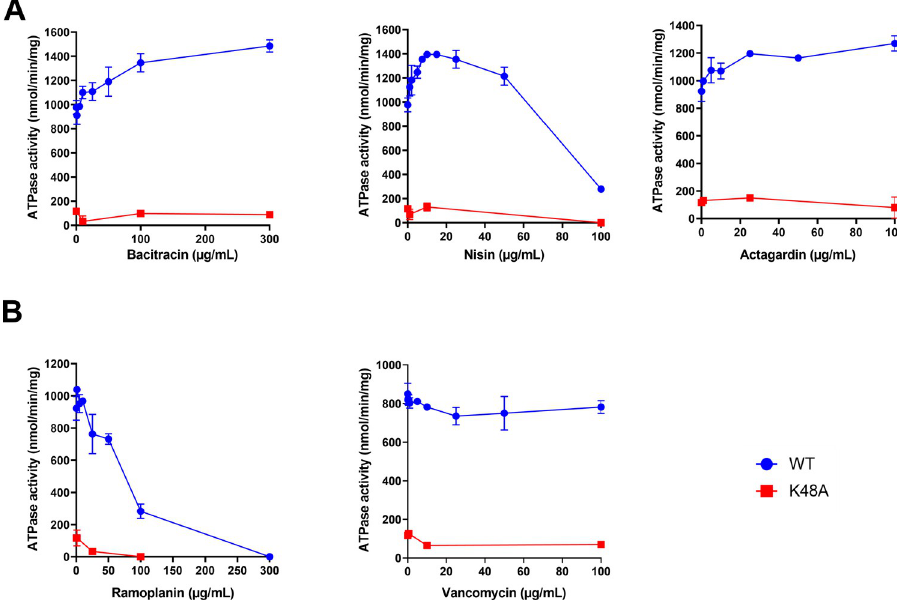
Fig 7. ATPase activity of BceAB in the presence of various antimicrobial peptides. (A) antimicrobial peptides to which BceAB confer resistance. (B) antimicrobial peptides to which BceAB does not confer resistance. Data shown are one representative experiment of at least two independent experiments and error bars indicate the standard deviation of triplicates.